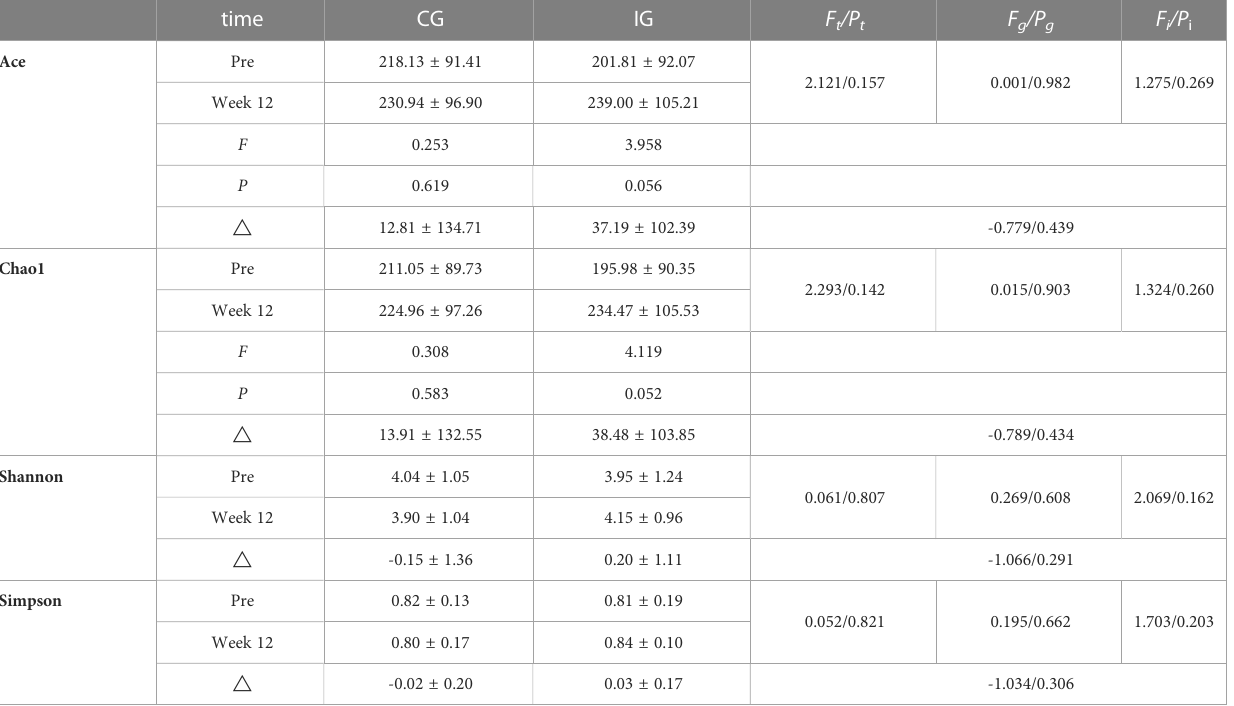
TABLE 6 Changes in the Alpha diversity indices in two groups (mean ± SD).